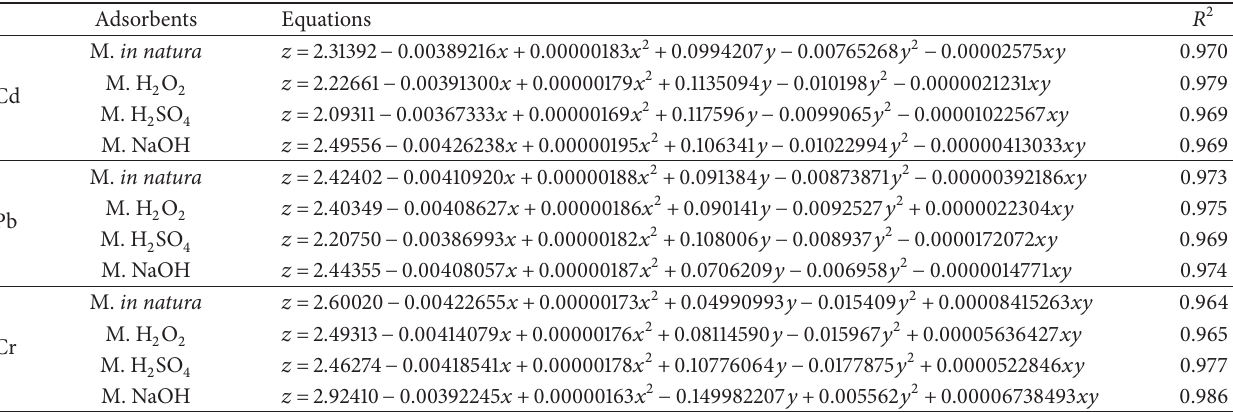
Table 5: Multiple quadratic mathematical equations obtained from the response surfaces for adsorption of Cd(II), Pb(II), and Cr(III) by adsorbents based on cassava peels, chemically modified and in natura